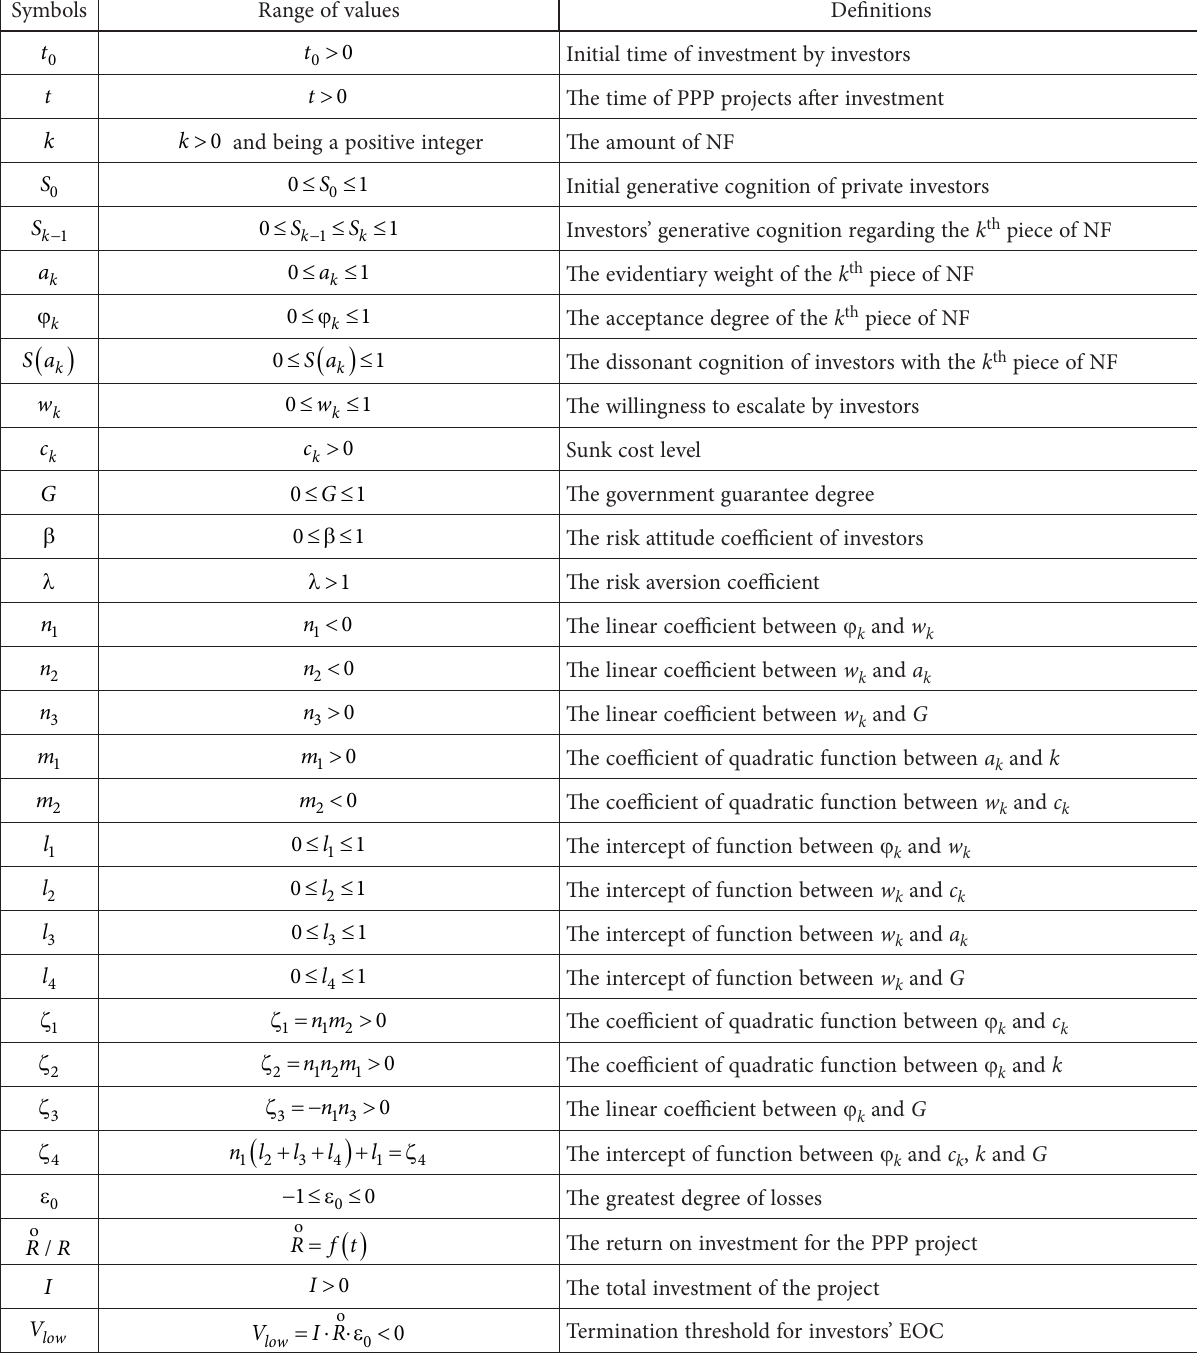
Table 1. The definitions of variables related to the threshold for investors’ EOC Symbols Range of values